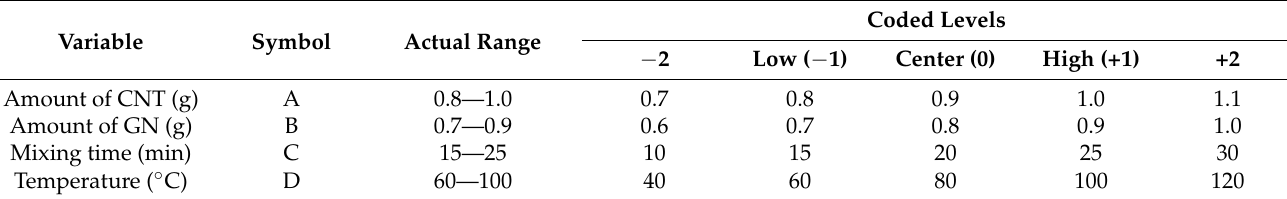
Table 1. Values and levels of chosen variables for central composite design.